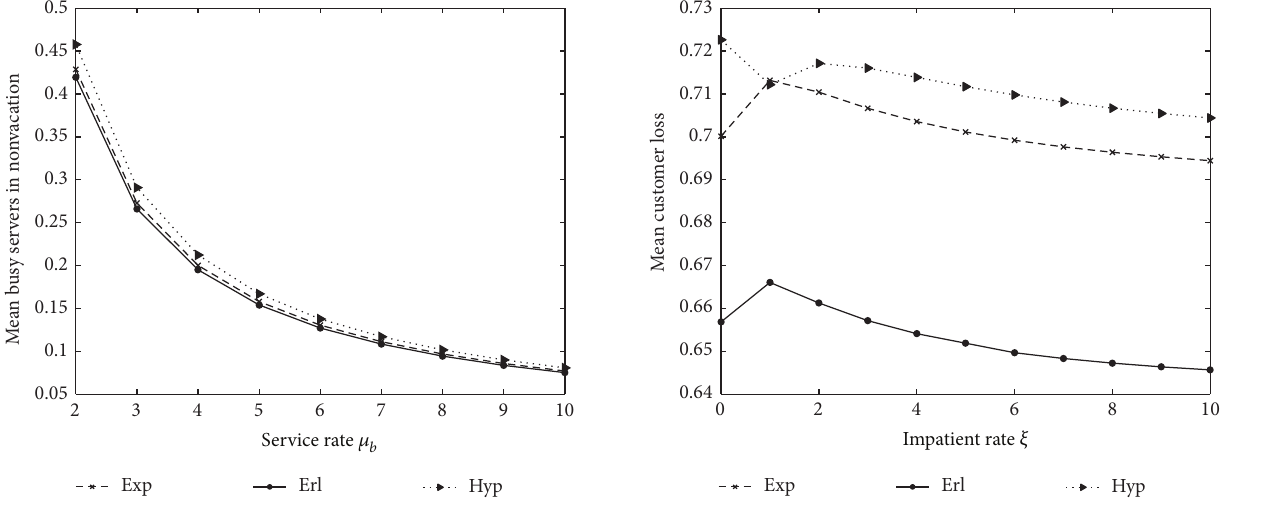
Figure 17: Mean number of busy servers versus service rate with 𝑐 = 1 , 𝜌 = 0.5 , 𝜉 = 0.1 , and 𝜇